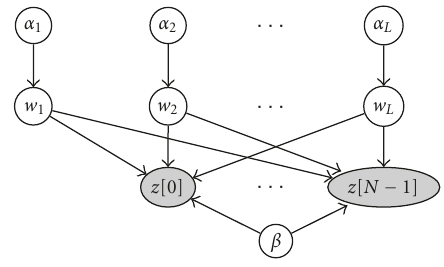
Figure 3: Graph representing the discrete-time model of the wire- less